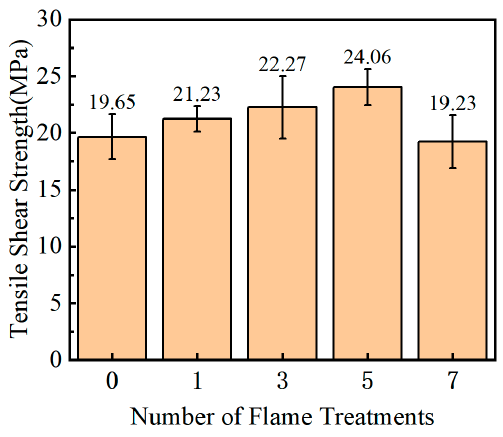
Figure 8. Tensile shear strength.